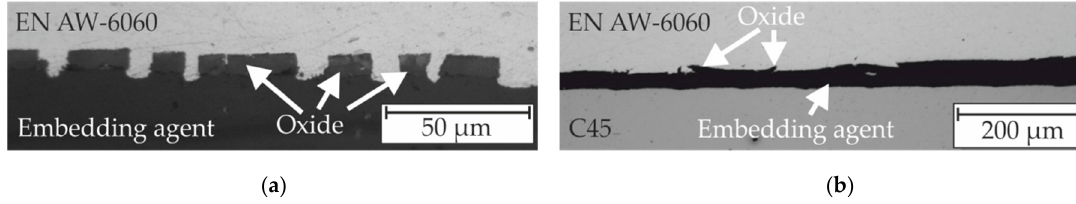
Figure 7. Polished cross section of the unwelded MPW sample joined with the EmGen setup (aluminum